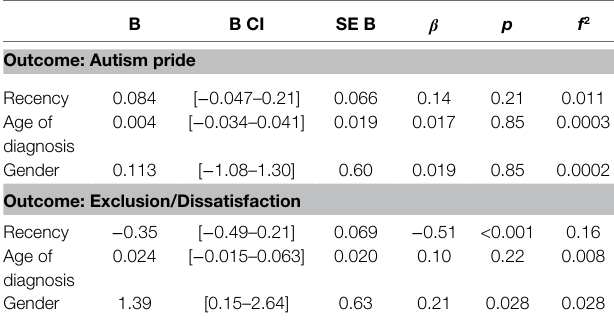
TABLE 4 | Regression results for the two multiple regressions with each of the Questionnaire on Disability Identity and Opportunity (QDIO) subscales as outcomes variables, and age, recency of diagnosis, and gender as the predictors.